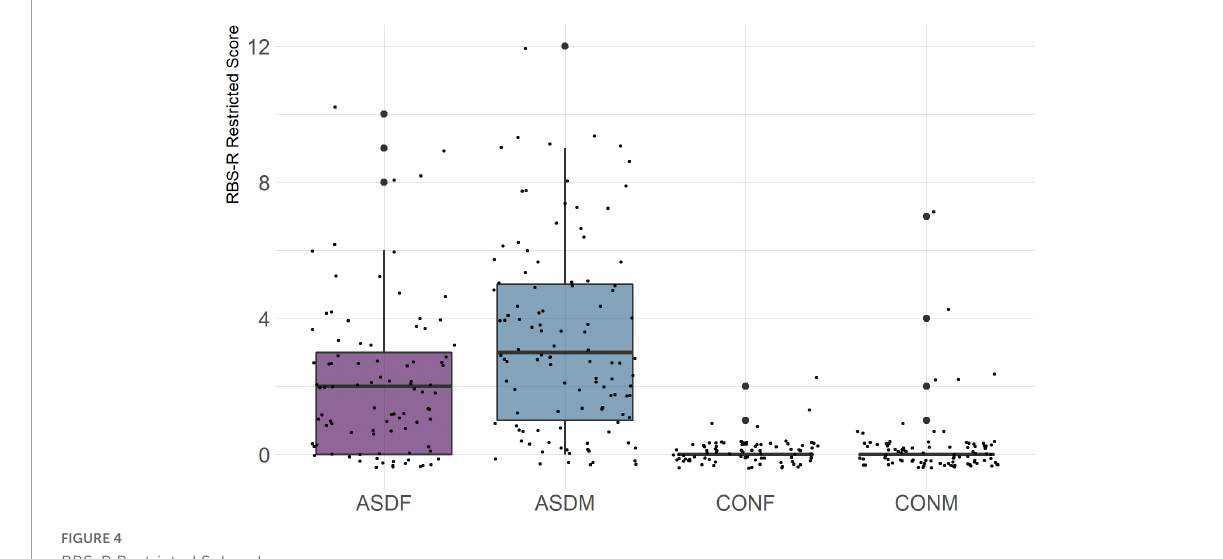
FIGURE4 RBS-R Restricted Subscale.